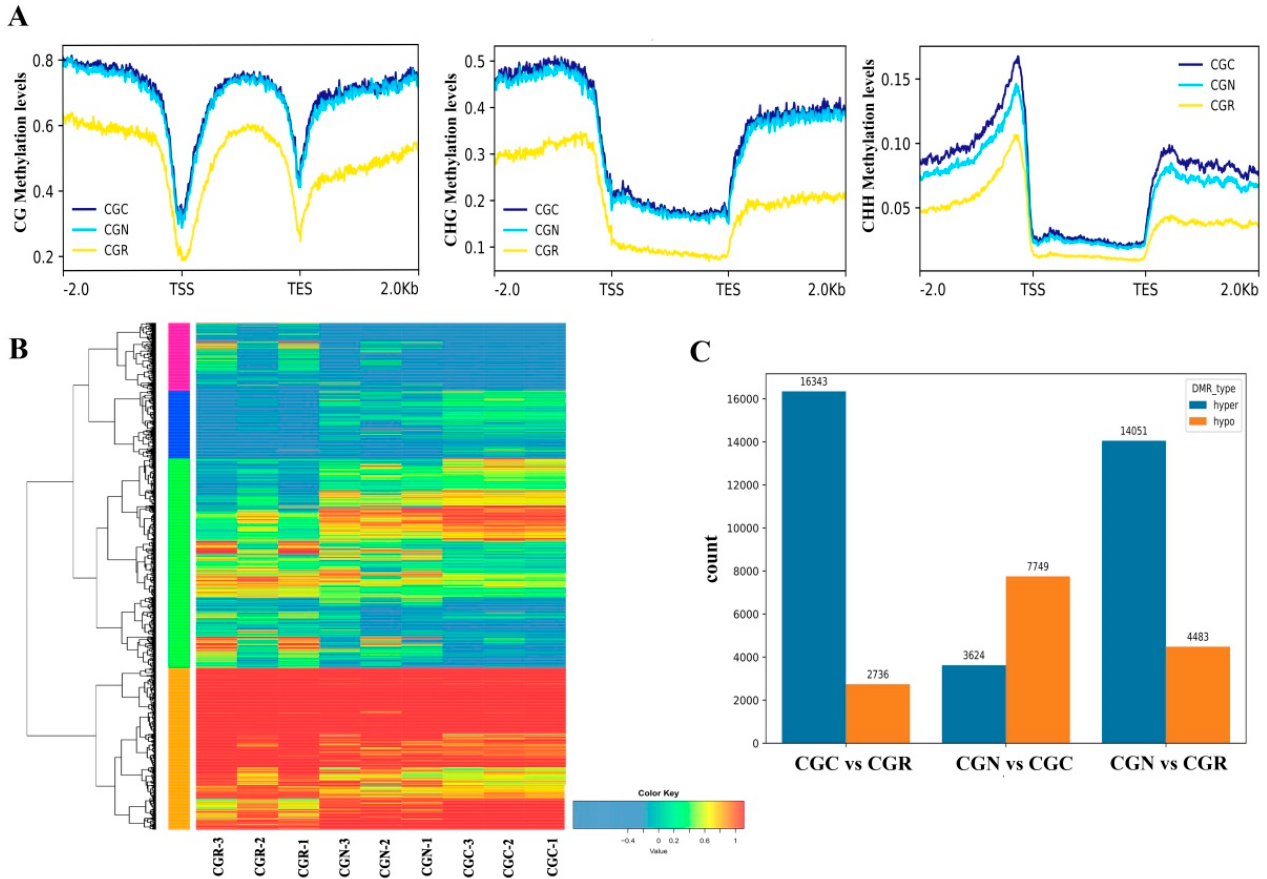
Figure 3. DNA methylation landscape of the rose. ( A ) Genome-wide profiles of CG, CHG, and CHH DNA across the top 7 chromosomes of the rose. The methylation levels of sequences of CG, CHG, and CHH samples subjected to different temperature treatments (6°C, 25°C, and 20 °C) are indicated from the outer to the inner rings. A 1 Mb window was used for calculating the gene/repeat density or methylation level. The red and blue lines inside represent high or low gene densities on the chromo- some, respectively. ( B ) Average methylation levels of CG, CHG, and CHH contexts of the roses sub- jected to different temperature treatments. ( C ) The relative proportion of CG, CHG, and CHH con- texts in the total number of methylation sites of rose samples under different temperature treatments.